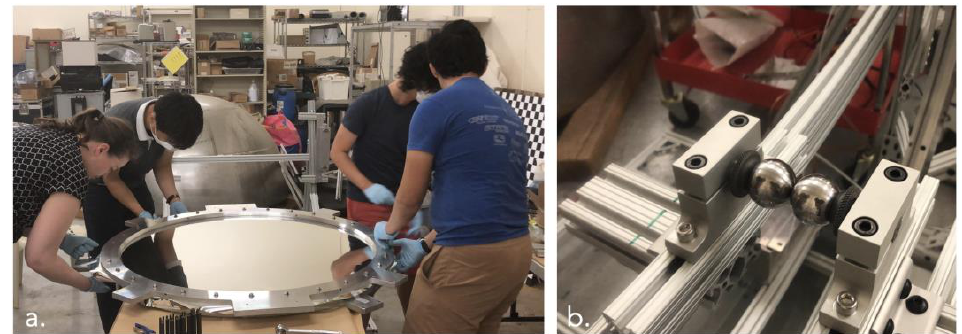
Figure 5. Four team members pull the reflective surface taut before clamping it the frame (a). One tooling ball just barely touches the rear side of the reflective mylar UUT (b). The full optomechanical mounting scheme for the 1 m mirror is described in detail [18].